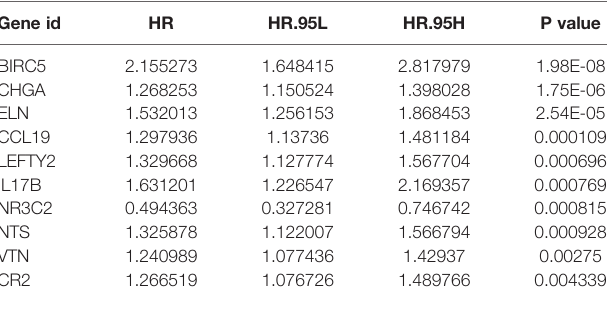
TABLE 2 | Top 10 genes in univariate Cox analysis.